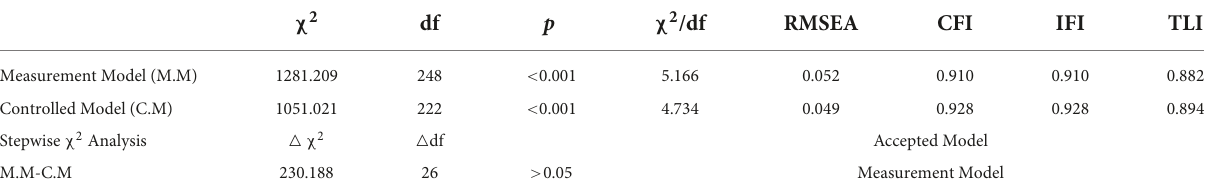
TABLE 4 Analysis of common method